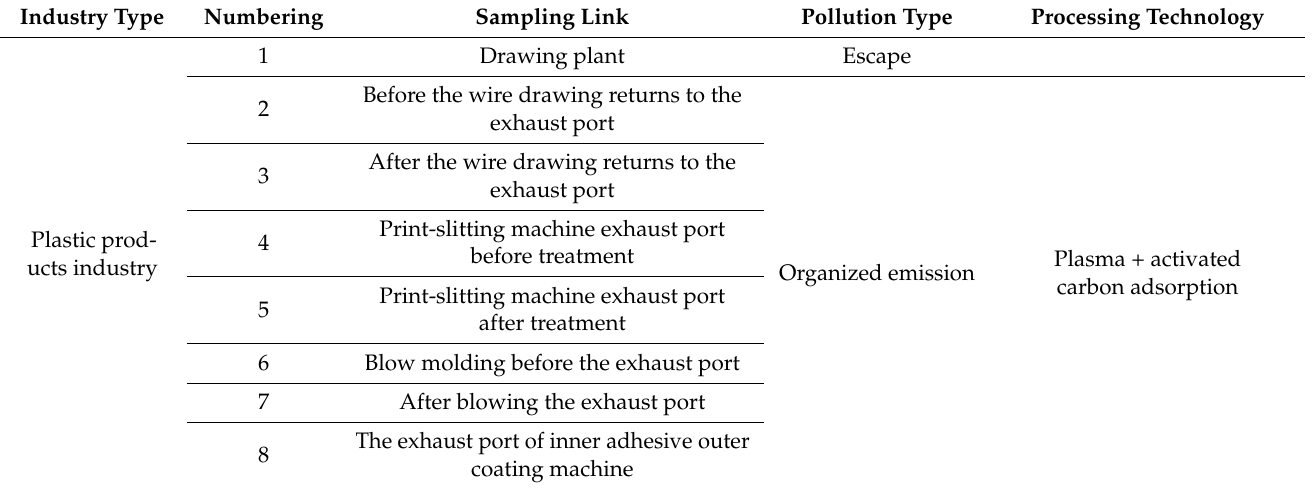
Table 1. Detailed information and emission concentrations of VOC industry emission